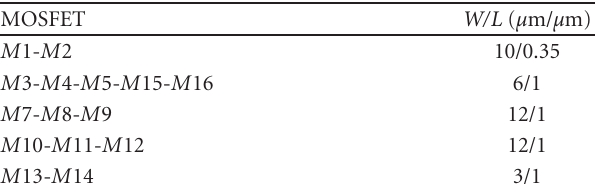
Table 1: Transistors widths for